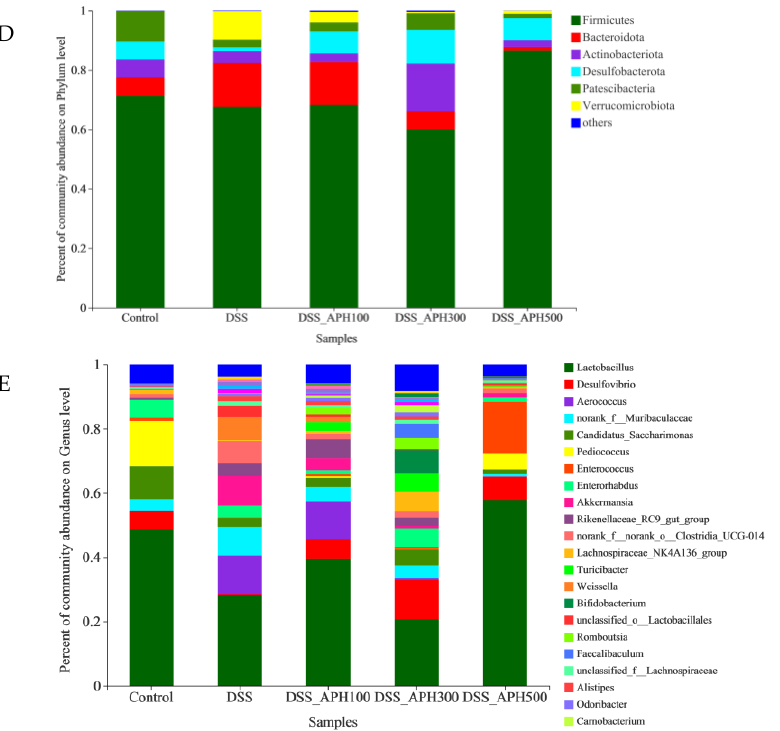
Figure 6. Effects of APH on the intestinal microbiota in mice with DSS-induced colitis. ( A ) Venn diagrams of OTU of each group; ( B ) principal coordinate analysis (PCoA); ( C ) rarefaction curve; ( D ) microbiota analysis at the phylum level; ( E ) microbiota analysis at the genus level.